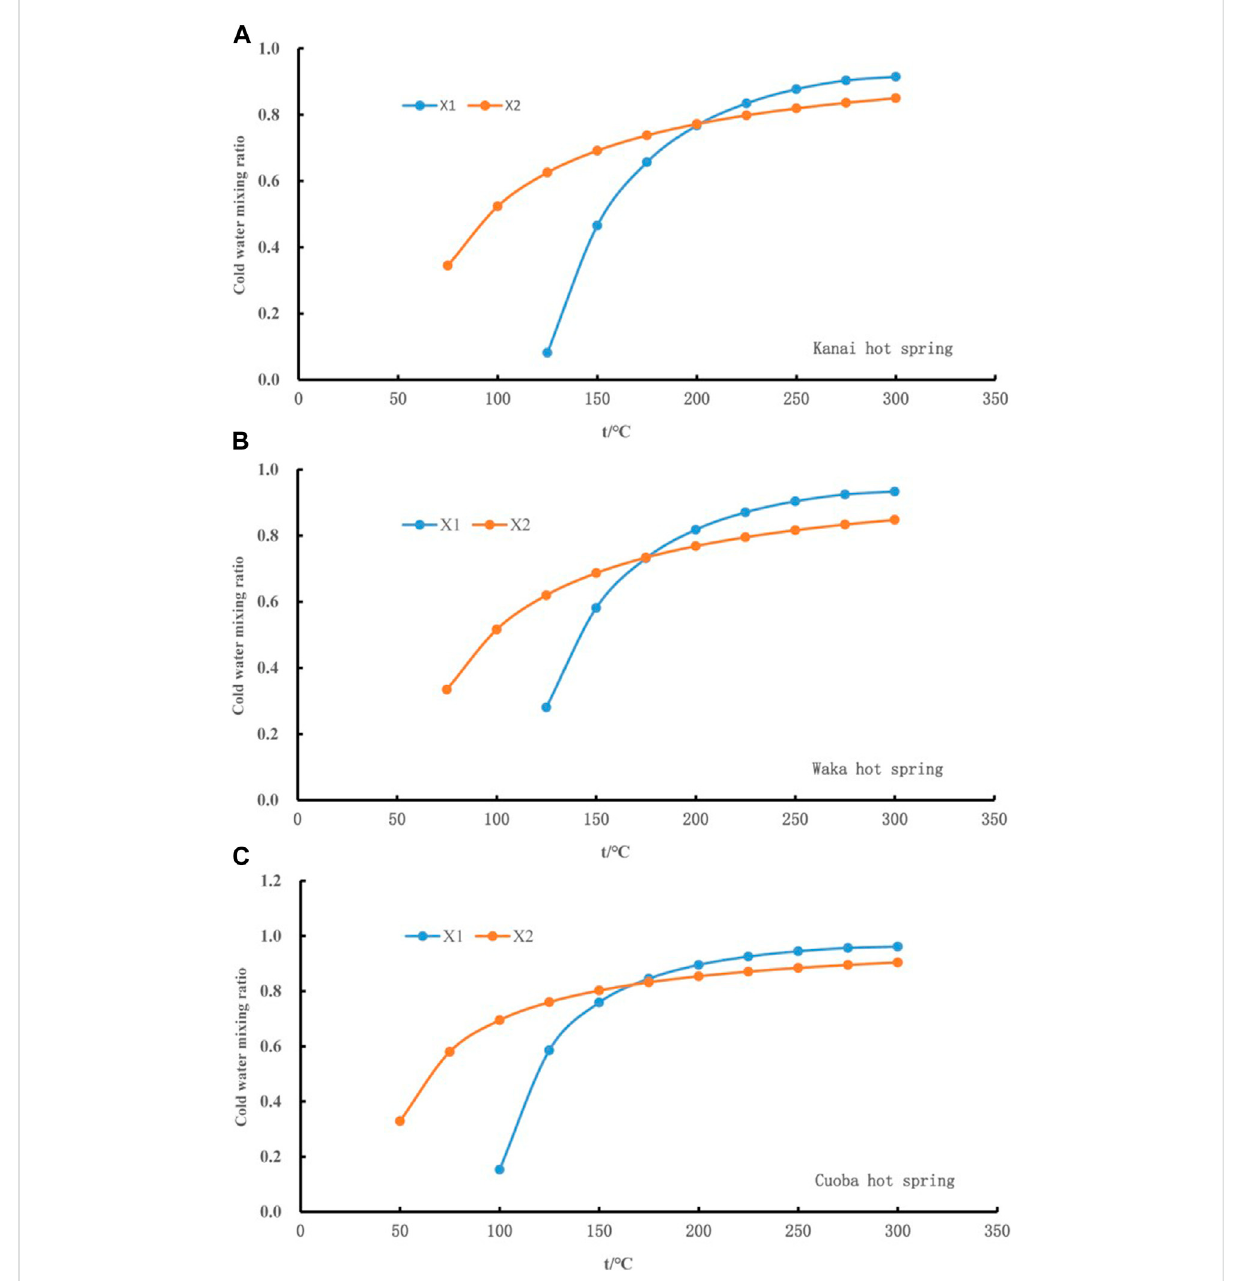
FIGURE 7 Relations between fraction of cold water and temperature in the mixing